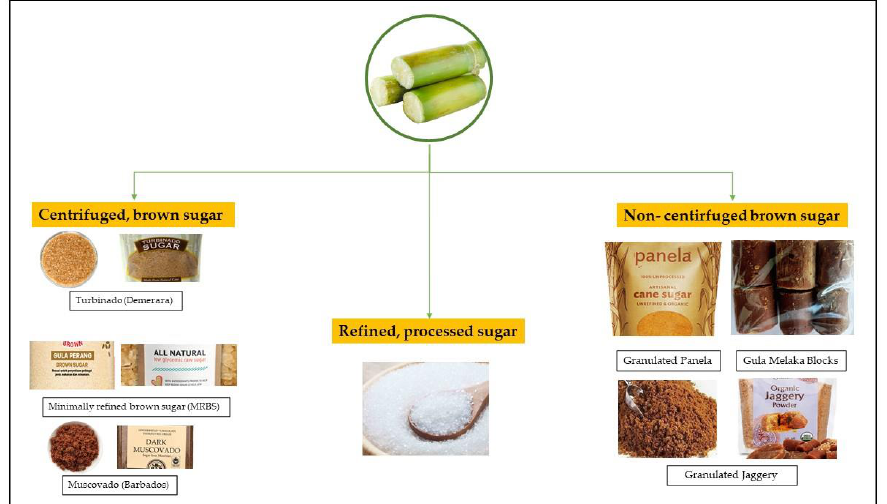
Figure 1. Various types of sugar processed from sugarcane. On the other hand, non-centrifugal sugar (NCS) is a whole cane sugar that is not centrifuged, and the molasses is not separated from the crystal, as can be seen in Figure 2. Depending on the country of origin, whole cane sugar goes by many different names, including panela in Latin America, jaggery in India and kokuto in Japan (Table 5) [19].